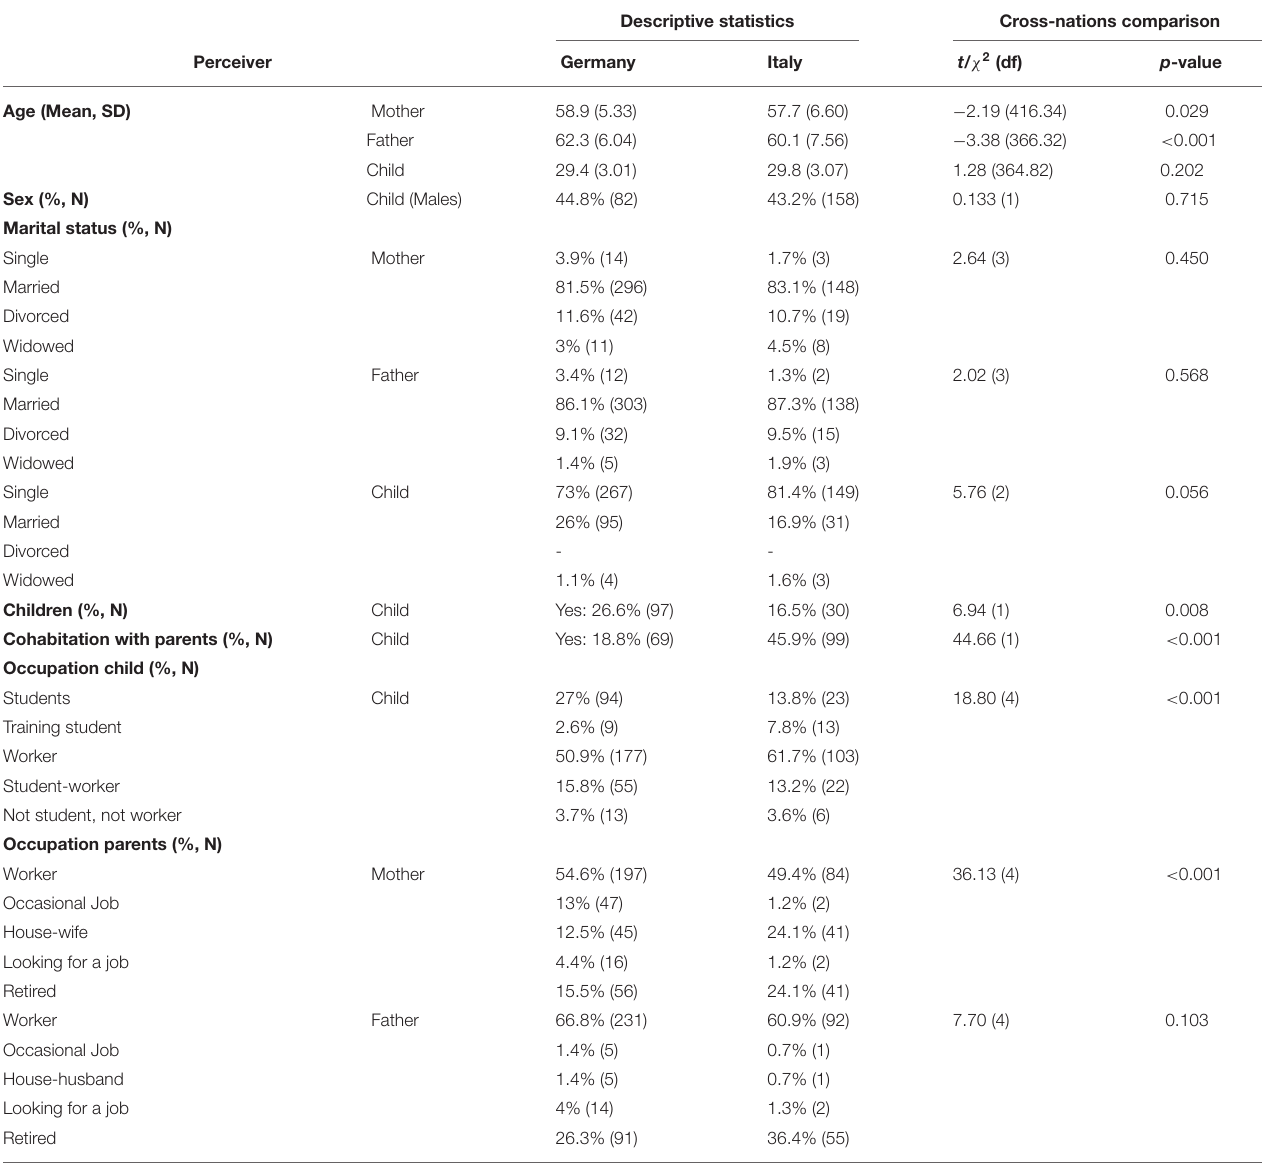
TABLE 1 | Descriptive statistics and cross-national comparison in Germany and Italy.